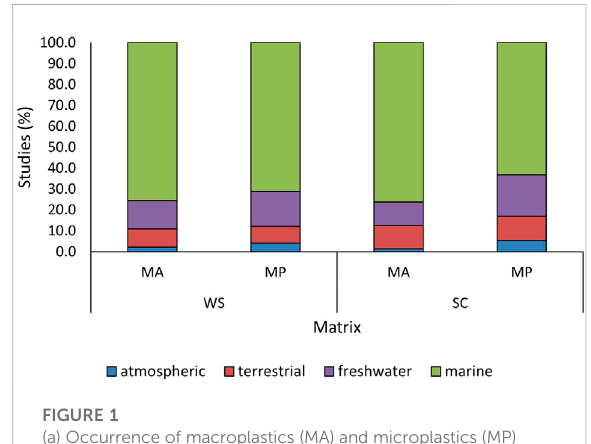
FIGURE 1 (a) Occurrence of macroplastics (MA) and microplastics (MP) in marine, freshwater, terrestrial, and atmospheric matrices. WS = Web of Science; SC =